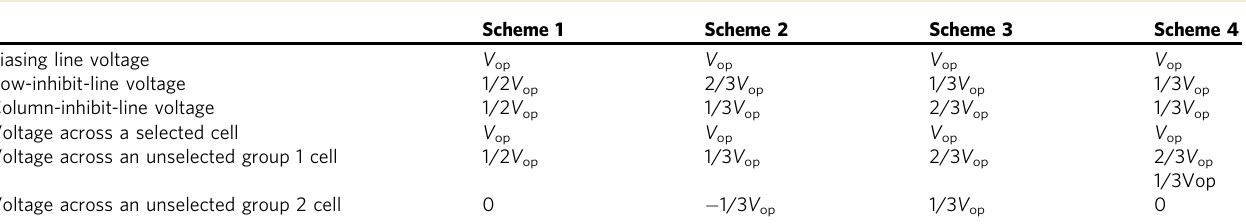
Voltage across an unselected group 2 cell